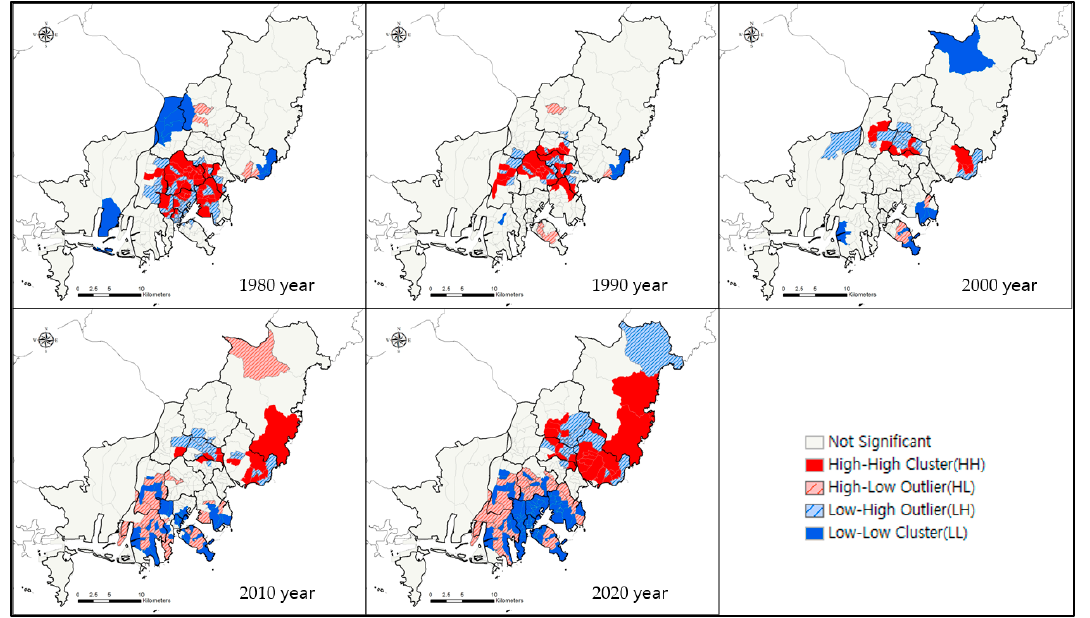
Figure 3. Spatial clusters of population in BMC. Note: The base map was adopted from the National Spatial Data Infrastructure Portal of Korea (www.nsdi.go.kr (accessed on 12 August 2022)). Table 2. Numbers of High-High (HH) and Low-Low (LL) clusters in